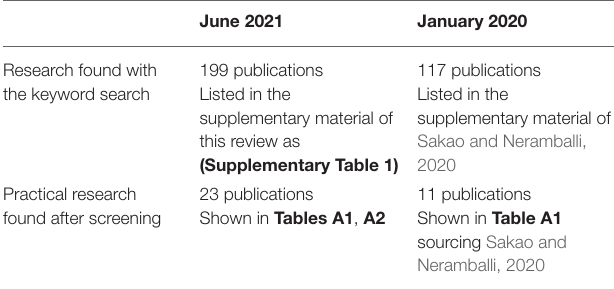
TABLE 1 | Numbers of publications found by the search and, thereafter,